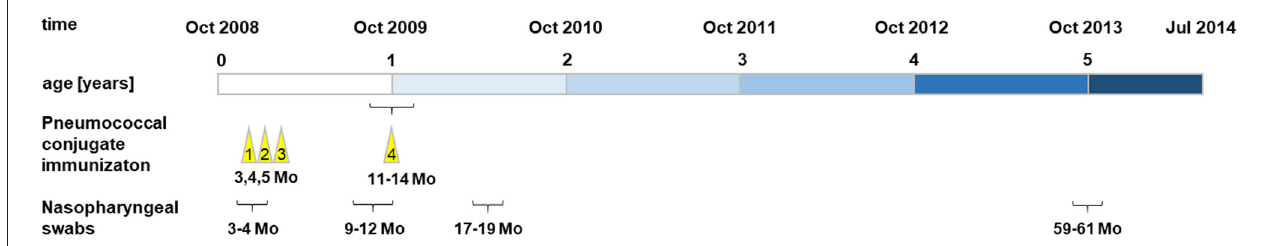
FIGURE 1 | Study design.